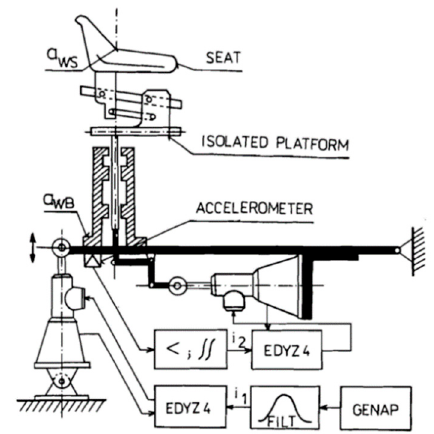
Figure 10. Active hydraulic control of a seat suspension system [56].